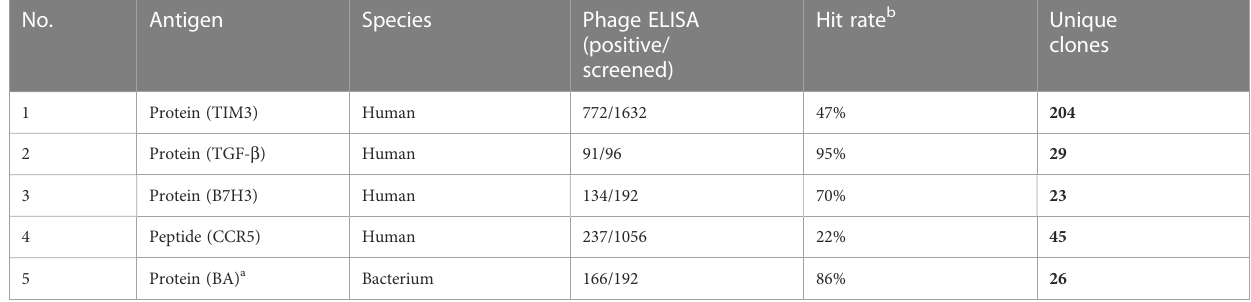
TABLE 2 Summary of panning